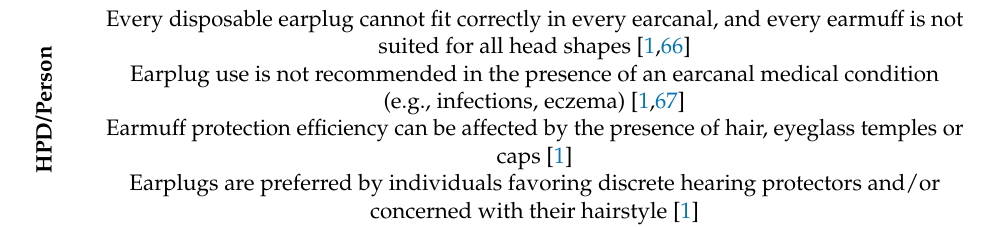
Table 2. Known incompatibilities between HPD characteristics and those of the two other triad